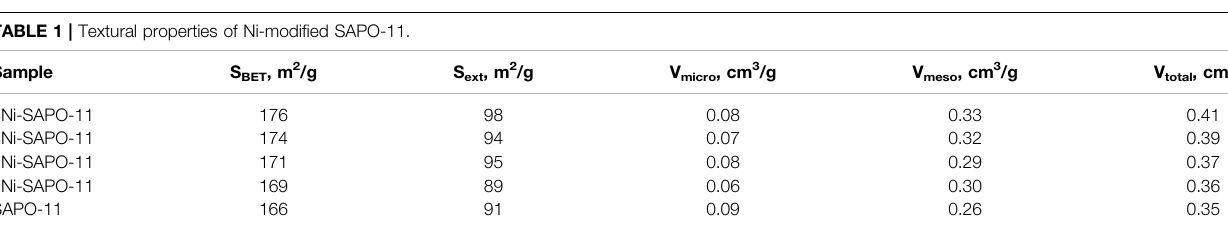
TABLE 1 | Textural properties of Ni-modi fi ed SAPO-11.